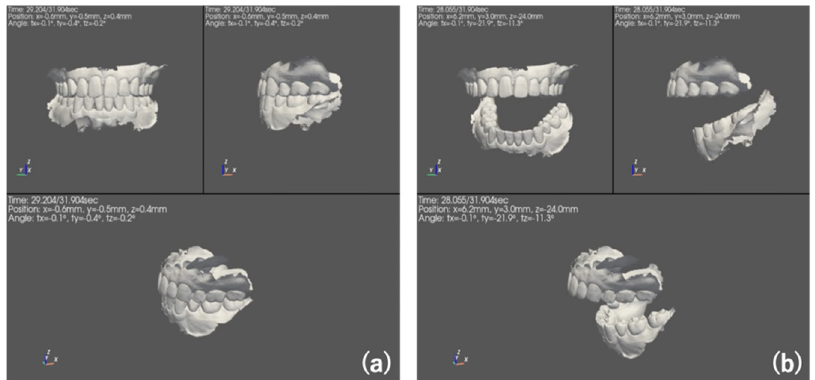
Figure 18. 3D reconstruction image at ( a ) mouth closing and ( b )